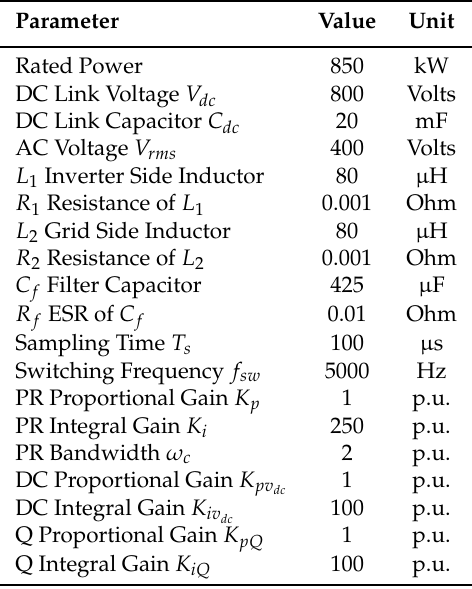
Figure 4. Voltage Source Converter (VSC) inner and outer control loop diagram for the study [20]. Table 2. VSC Main